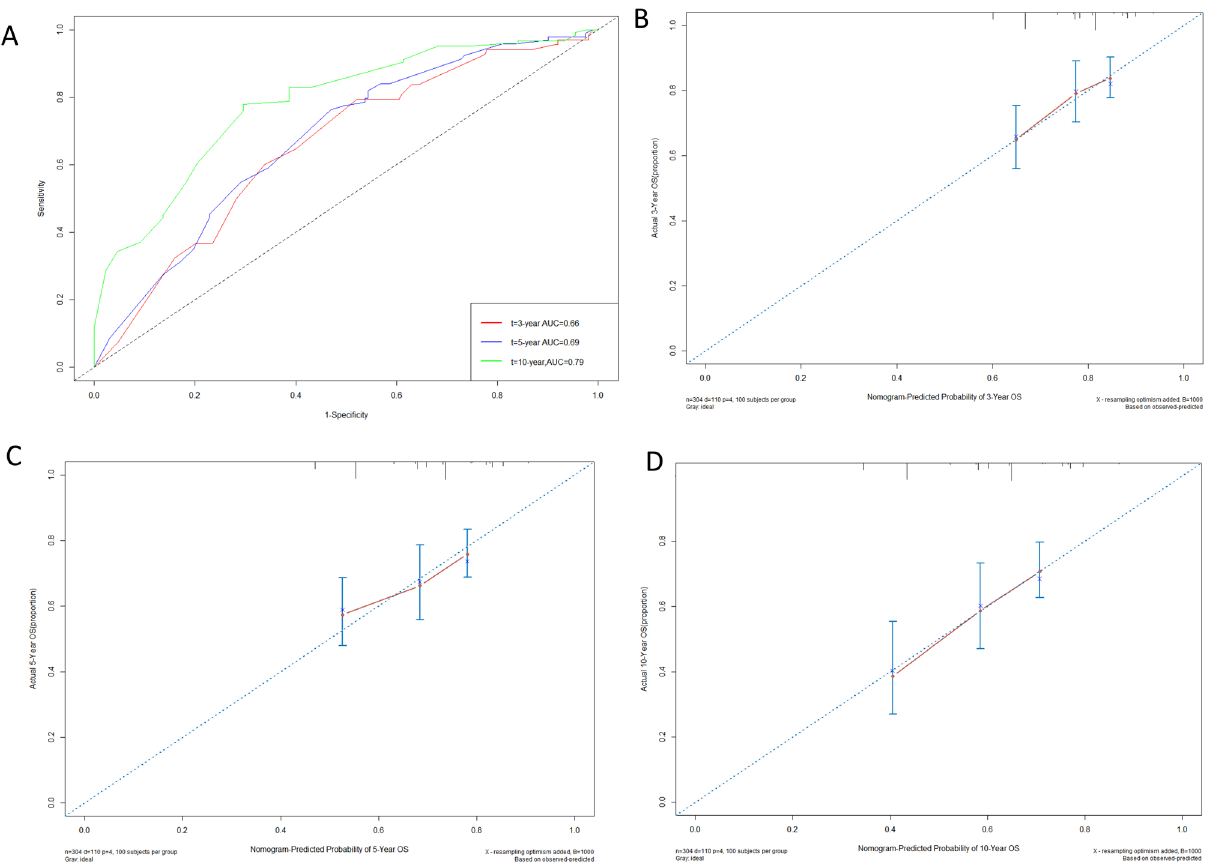
Figure 3. (A) ROC curves for 3-, 5-, and 10-year OS based on the nomogram for the training cohort. ( B) Calibration curve of predicted 3-year OS. ( C) Calibration curve of the predicted 5-year OS. ( D) Calibration curve of the predicted 10-year